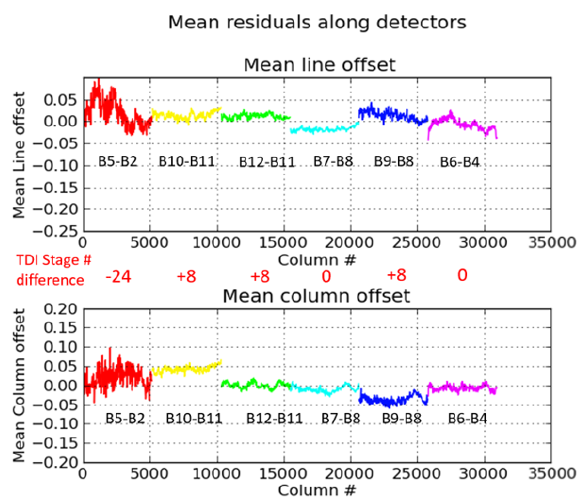
Figure 17. Inter-band registration residuals after calibration with a TDI rigorous geometric model (same product as previous Figure 16). Inter-band magnifications were corrected. Constant biases were partially corrected down to 0.05 pixel.